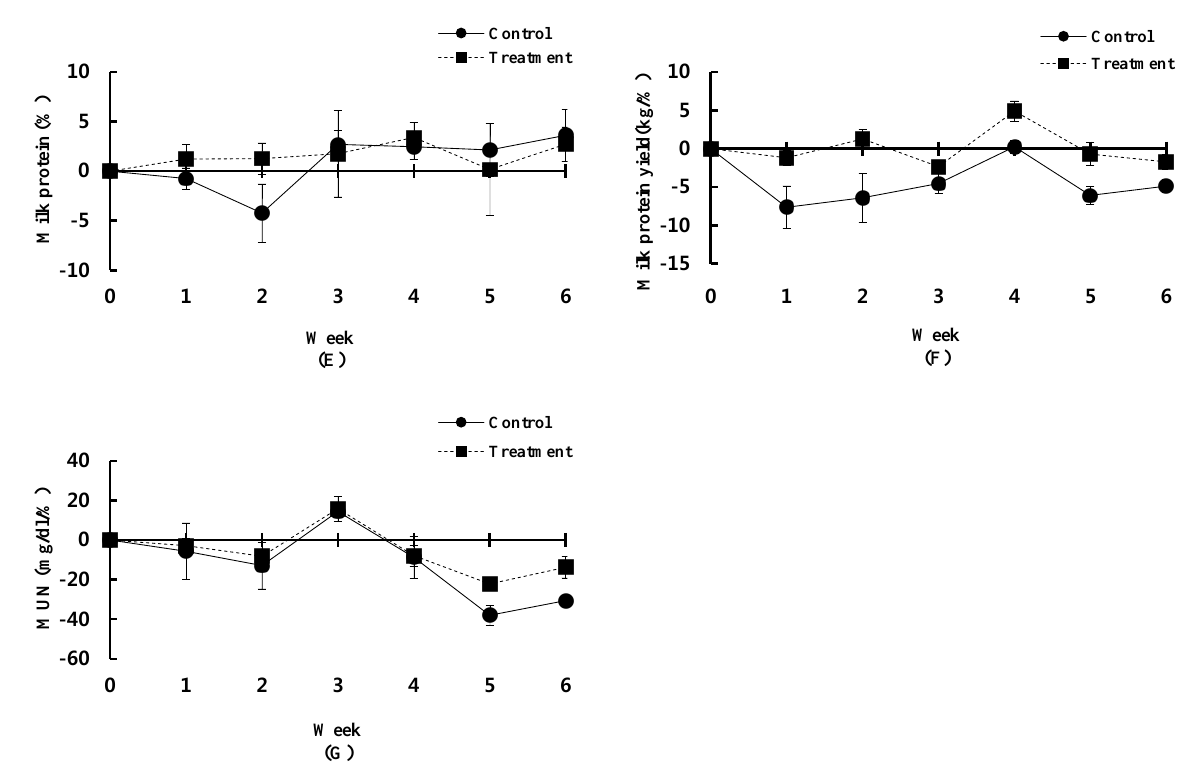
Figure 1. ii) Effect of RPAAs and RPF supplementation on milk (A) yield (kg/%), (B) 4% fat corrected milk (FCM) (kg/%), (C) fat (%), (D) fat yield (kg/%), (E) protein (%), (F) protein yield (kg/%), (G) MUN (milk urea nitrogen) yield (mg/dL/%) of Holstein-Frisian dairy cows (Index against 0%). Control group fed basal diet only (no addition of RPAAs and RPF), and the treatment group fed basal diet with 50 g of RPAAs (50% of RPLys and RPMet [3:1 ratio]) and 50 g of RPF ( 98% of RPF ) twice a day (total 100 g of each RPAAs and RPF/d). RPAAs, ruminally protected amino acids; RPF, ruminally protected fat; RPLys, ruminally protected lysine; RPMet, ruminally protected